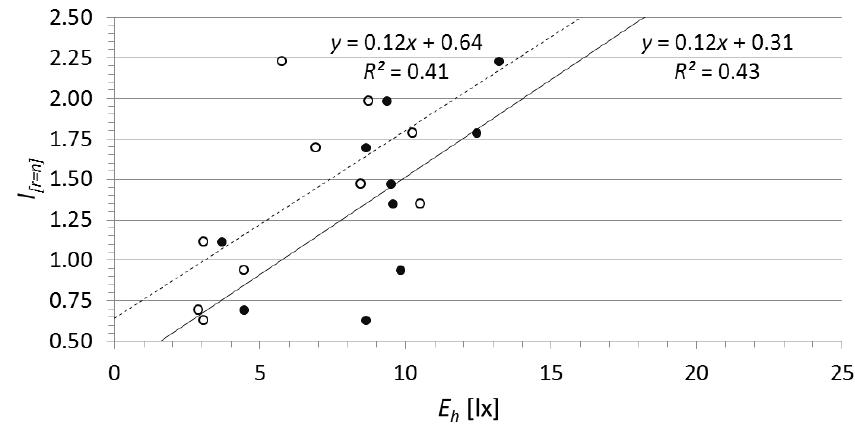
Figure 16. Scenario 2 (design status): correlations between I and E h,av (black circles and a continuous line for the regression) and between I and E h,min (white circles and a dotted line for the regression) on the sidewalks on the same side of luminaires.